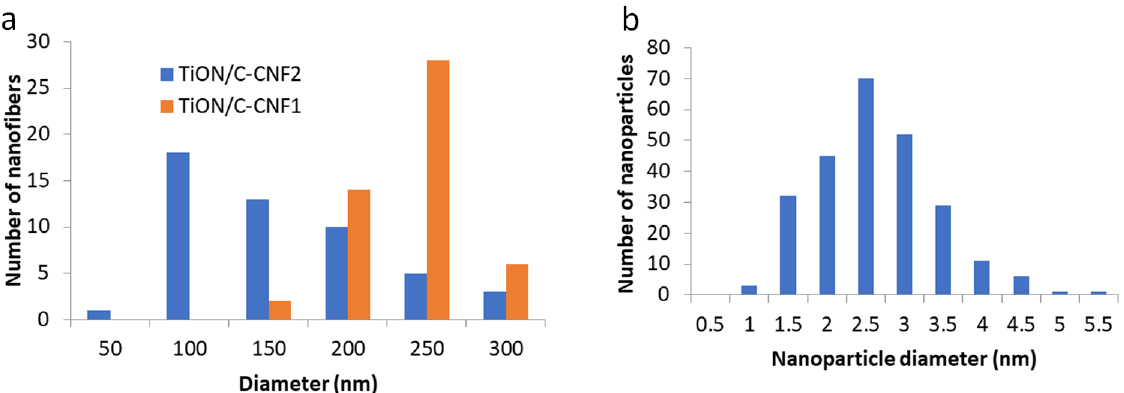
Figure 2. Diameter size distribution of 50 Titanium oxynitride carbon composite nanofibers (1st sample, TiON/C-CNF1s) and TiON/C-CNF2s ( a ) and particle size distribution of 250 nanoparticles of TiON/C-CNF2 sample ( b ). Distributions were determined from images in Figures S1 and S3 in Supplementary Materials.